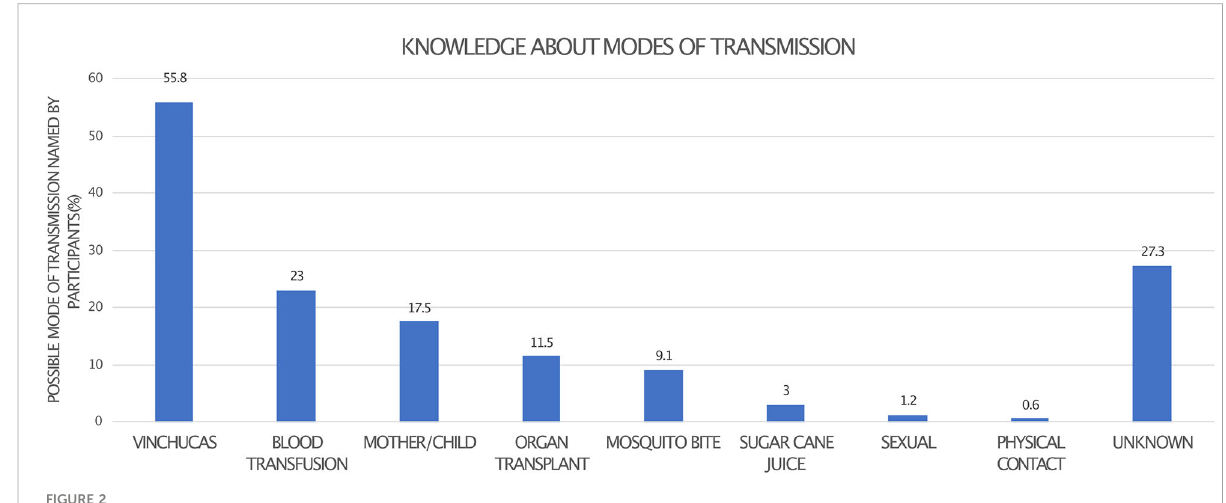
FIGURE 2 Participants were asked to name all correct modes of CD